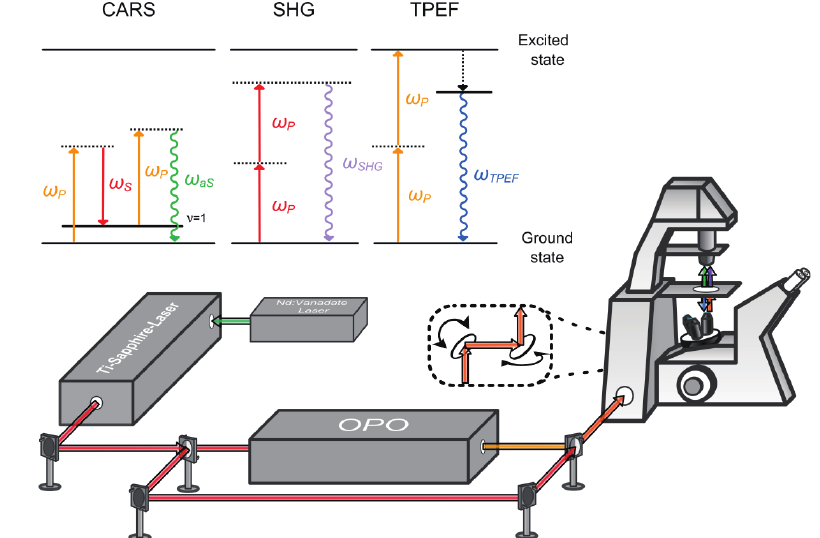
Figure 1. Experimental setup for the multimodal investigation of non-melanoma skin cancer (NMSC) and schematic representation of the three non-linear contrast mechanisms, i.e. , coherent anti-Stokes Raman scattering (CARS), two photon excited fluorescence (TPEF) and second harmonic generation (SHG).